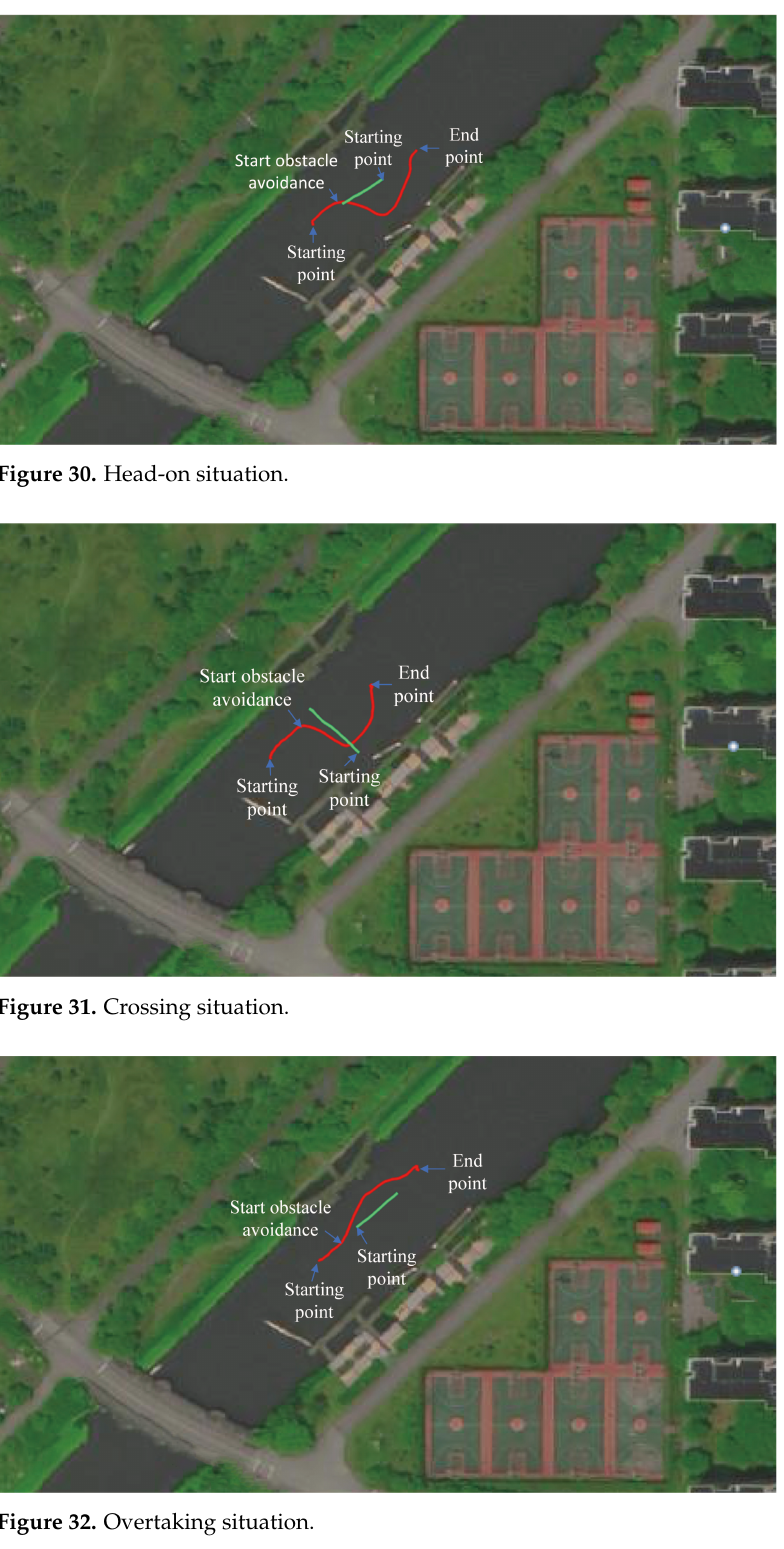
Figure 32. Overtaking